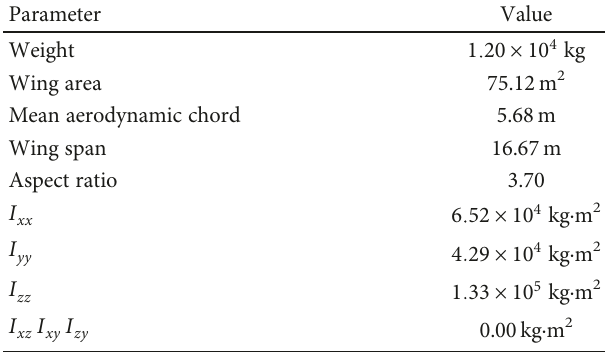
Table 1: Summary of EQ model physical parameters.